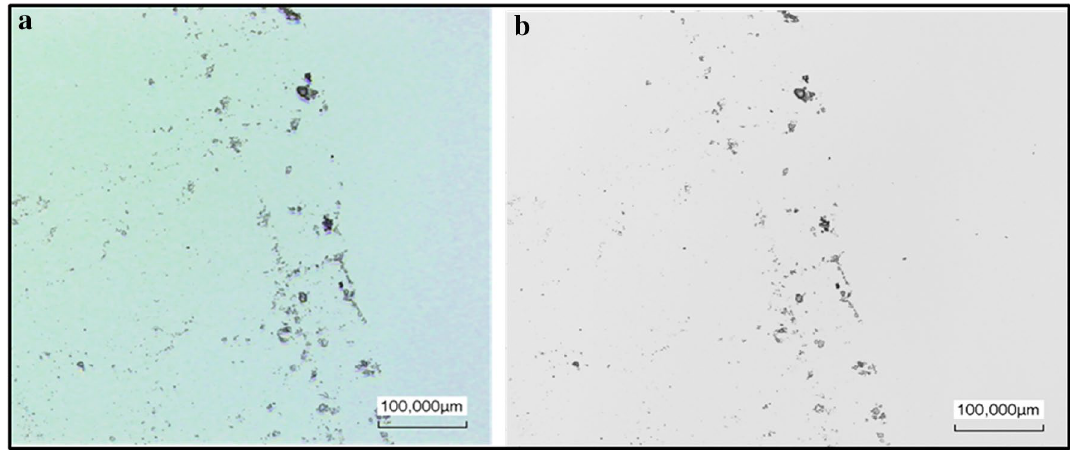
Fig. 1 Light microscopic characterization of a greasy human fingerprint deposited on a mirror-polished surface of a silicon wafer, a after deposition and b after APP treatment